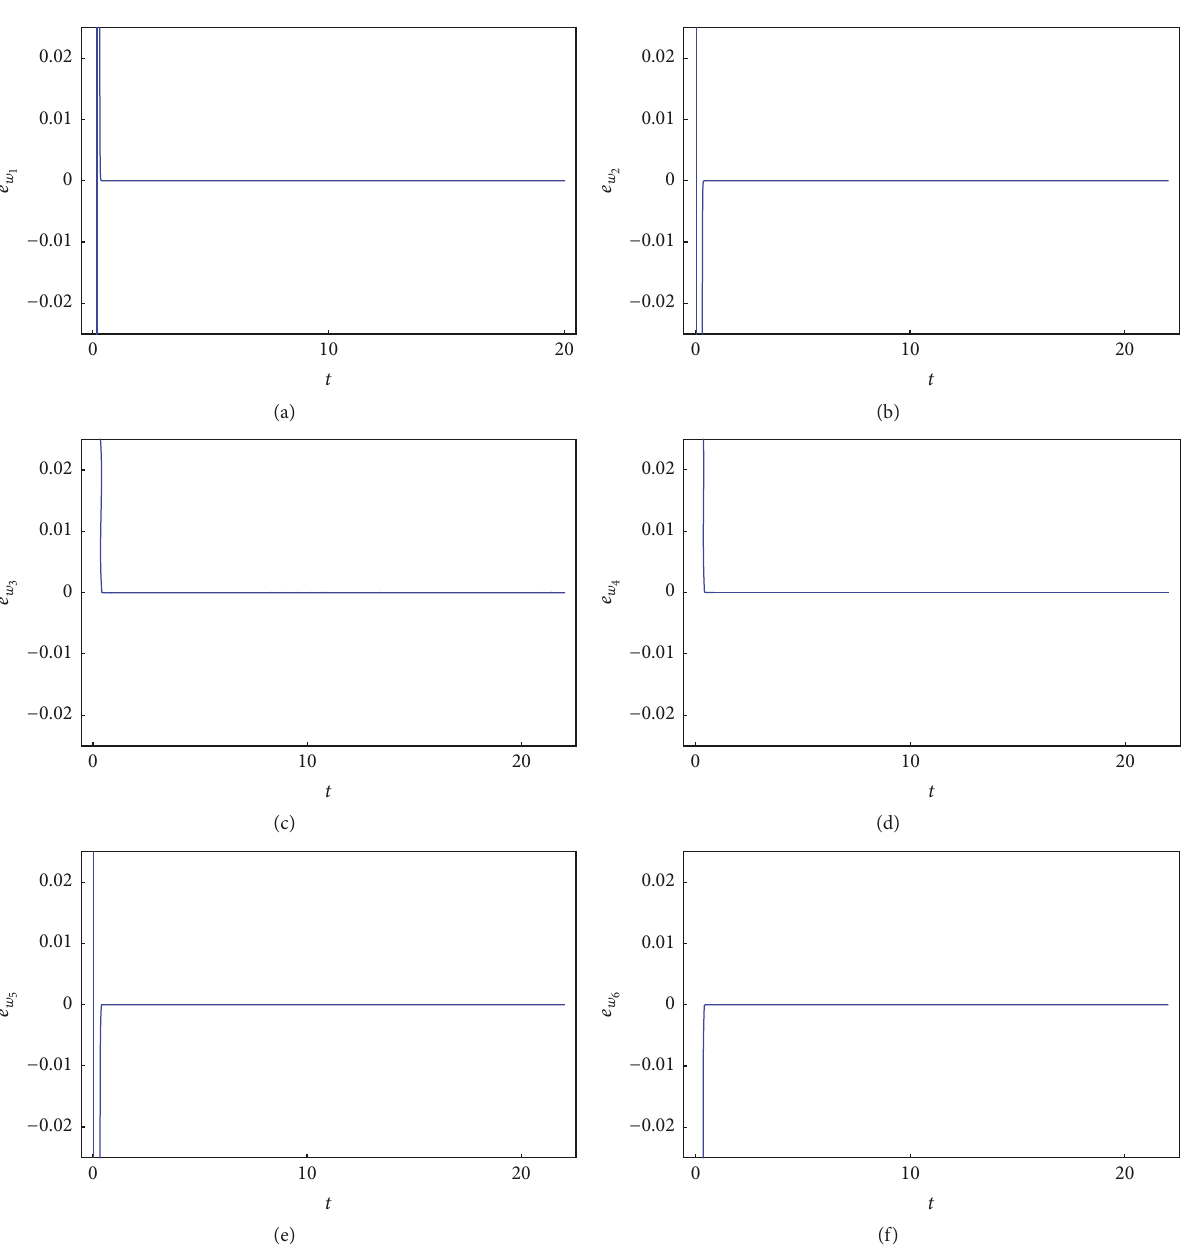
Figure 5: CALS errors between systems (34) and (35): (a) 𝑤 1𝑠 (𝑡)−𝑤 2𝑚 (𝑡−𝜏) . (b) 𝑤 2𝑠 (𝑡)+𝑤 1𝑚 (𝑡−𝜏) . (c) 𝑤 3𝑠 (𝑡)−𝑤 4𝑚 (𝑡−𝜏) . (d) 𝑤 4𝑠 (𝑡)+𝑤 3𝑚 (𝑡−𝜏) . (e) 𝑤 5𝑠 (𝑡) − 𝑤 6𝑚 (𝑡 − 𝜏) . (f) 𝑤 6𝑠 (𝑡) + 𝑤 5𝑚 (𝑡 − 𝜏)